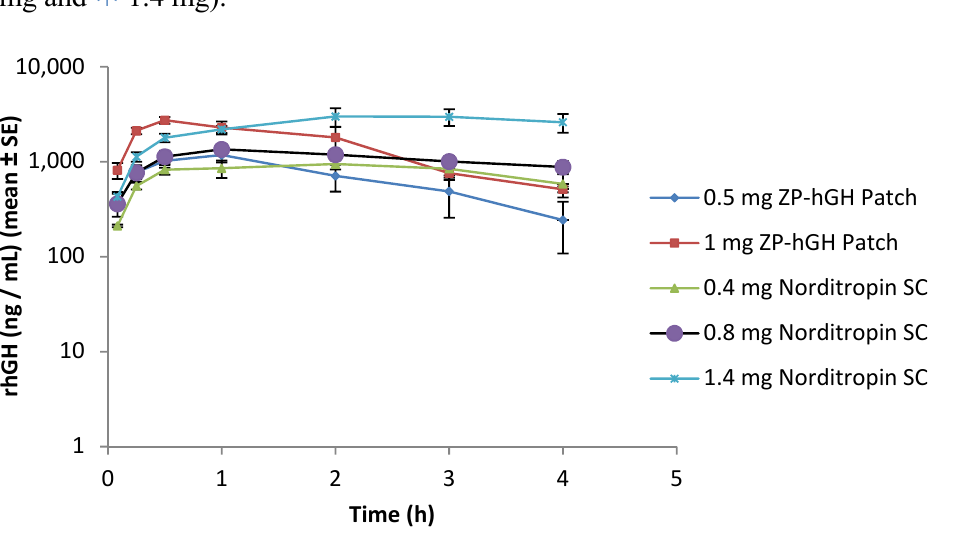
Figure 6. Pharmacokinetic (PK) profile of rhGH delivered by microneedle patch or SC injection: ZP-hGH patch (  0.5 mg and  1 mg); Norditropin ® SC injection  0.4 mg,  0.8 mg and  1.4 mg).